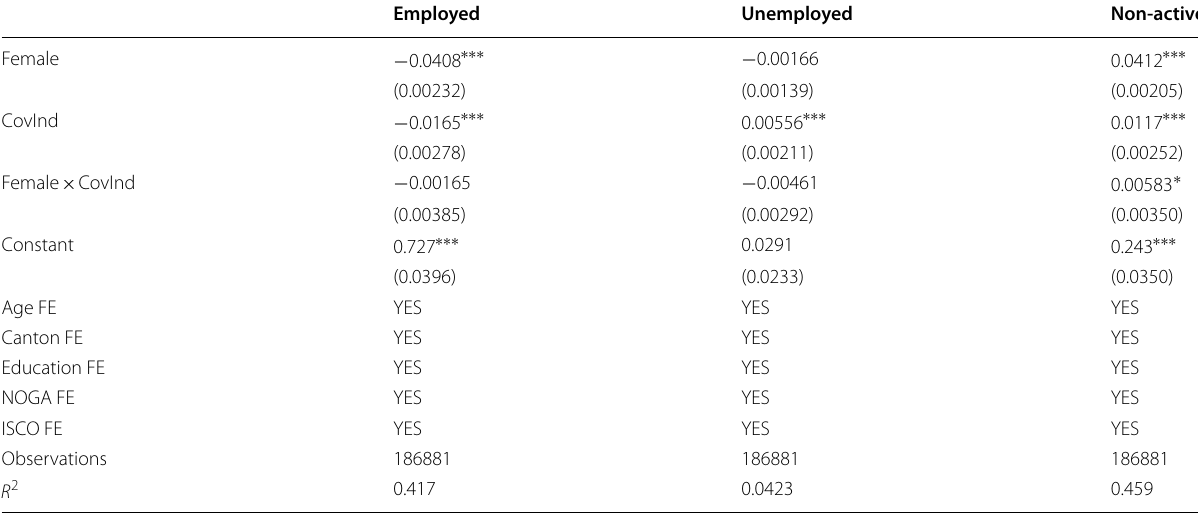
Estimates from regression (1) of labor market status on a constant, female dummy (1 for women and 0 otherwise), COVID-19 stringency index and its intersection with the female dummy. Sample includes respondents aged 15 to 64. Regressions estimated with linear probability model, including random effects. Robust standard errors in